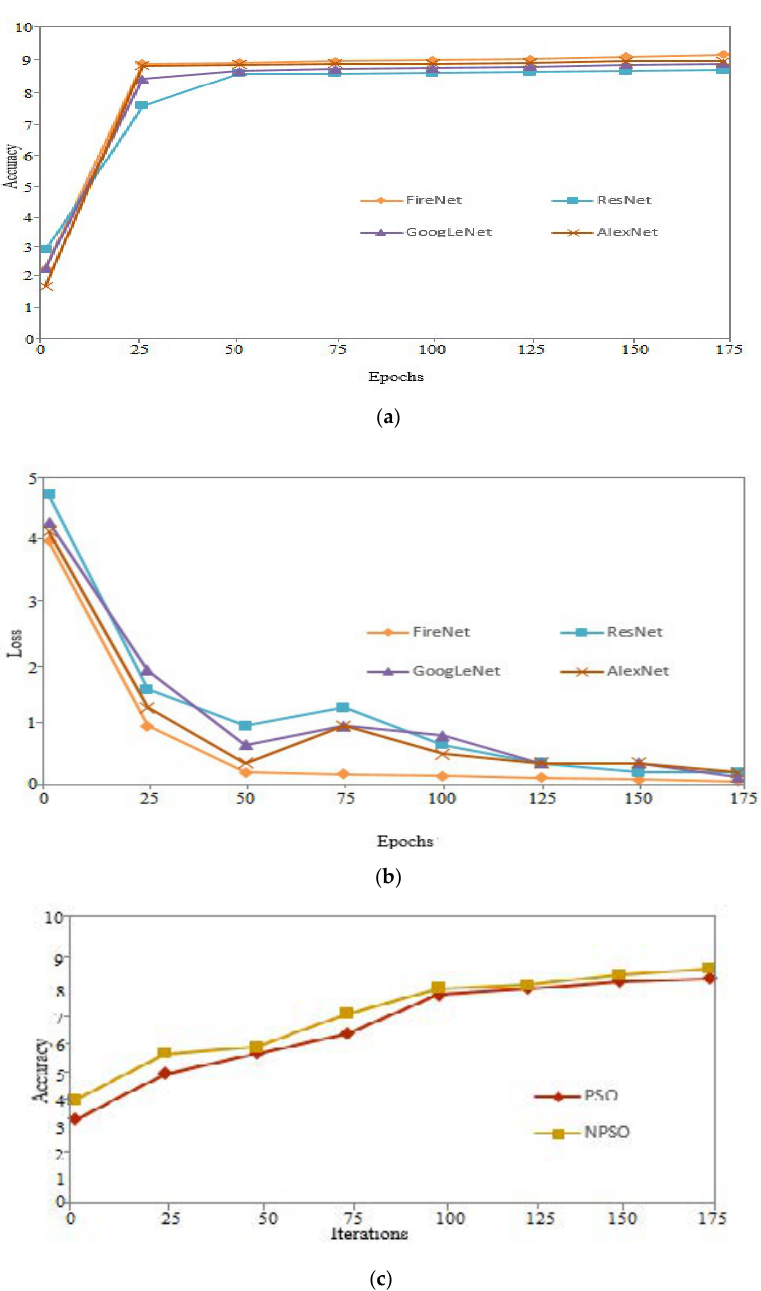
Figure 9. Training progress of our proposed FireNet model with the state-of-the-art deep learning models by using NPSO method. ( a ) illustrates the performance of FireNet with the state-of-the-art deep learning models during the training phase. ( b ) illustrates the performance of FireNet with the state-of-the-art deep learning models during the training loss phase. ( c ) shows the performance of the proposed FireNet model versus NPSO and PSO.